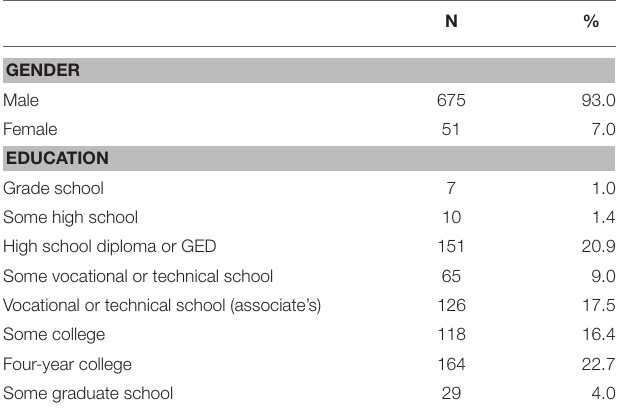
TABLE 2 | Respondent